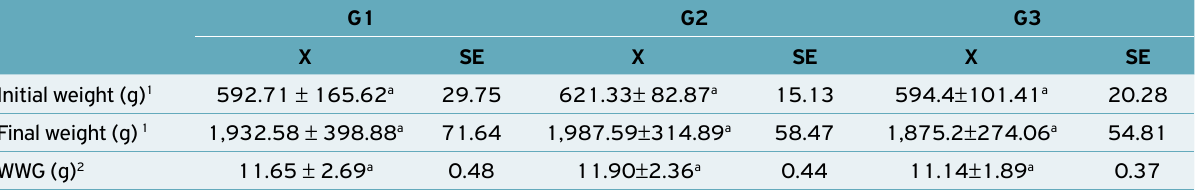
Table 2. Initial weight, final weight and weekly weight gain (GG) of groups (G) of unvaccinated birds (G1) and vaccinated with one dose at week 8 (G2) and two doses at 8 to 11 th week of age (G3). G1